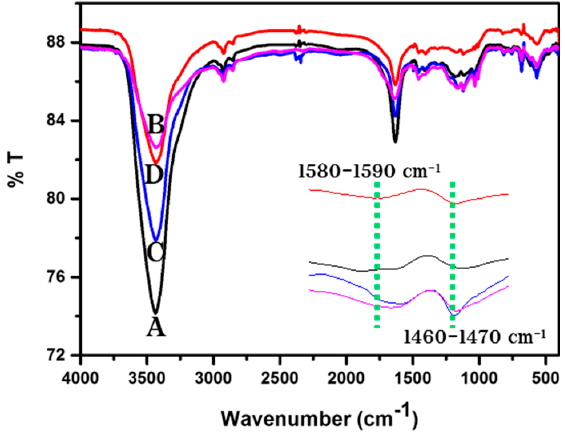
Figure 2. Fourier-transform infrared (FTIR) spectrum of ( A ) G/PANI/FG1; ( B ) G/PANI/FG2; ( C ) G/PANI/FG3; and ( D ) PANI/GNG.